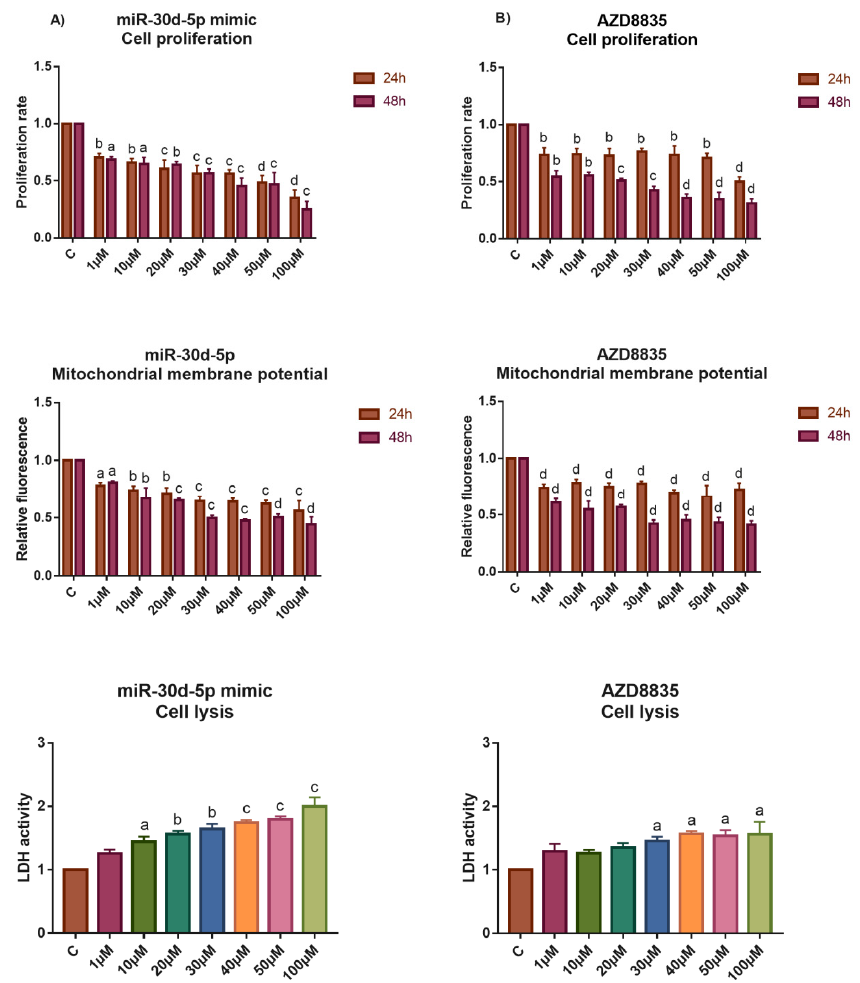
Figure 6. Study the effect of high-dose E2 exposure to the cell proliferation, apoptosis and cell lysis of the PEO1 cell cultures in the presence of miR-30d-5p mimic or AZD8835. Phenotypic characterization of high-dose E2 treatment was made in the PEO1 cell line in the presence of 50 nM miR-30d-5p mimic ( A ) or 100 nM AZD8835 ( B ). The rate of cell proliferation, mitochondrial membrane potential (24 h and 48 h after the treatment), and LDH activities (48 h after the treatment) were determined relative to the non-treated control (1). Data are presented as the mean ± S.D. a: p < 0.05; b: p < 0.01; c: p < 0.001; d: p <